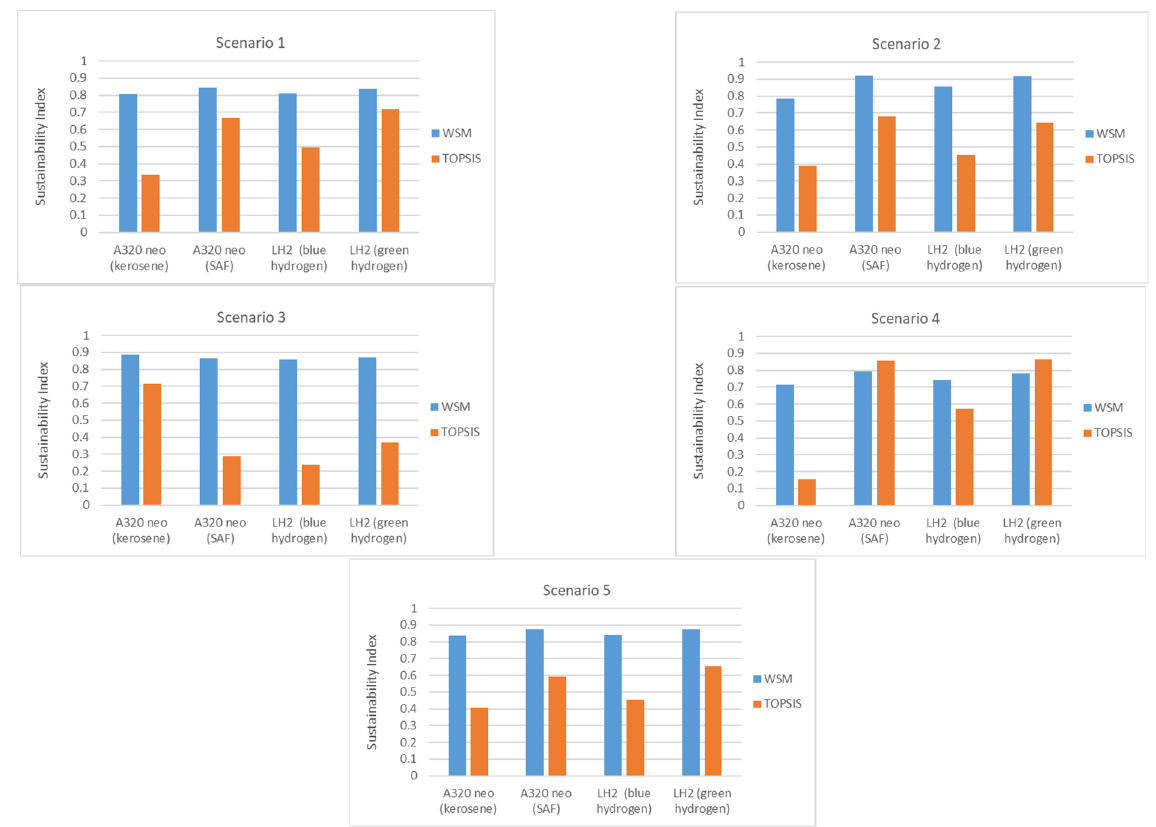
Figure 2. Comparison of WSM and TOPSIS aircraft ranking for the five scenarios considered . Table 4. Comparison of AHP-WSM with AHP-TOPSIS .